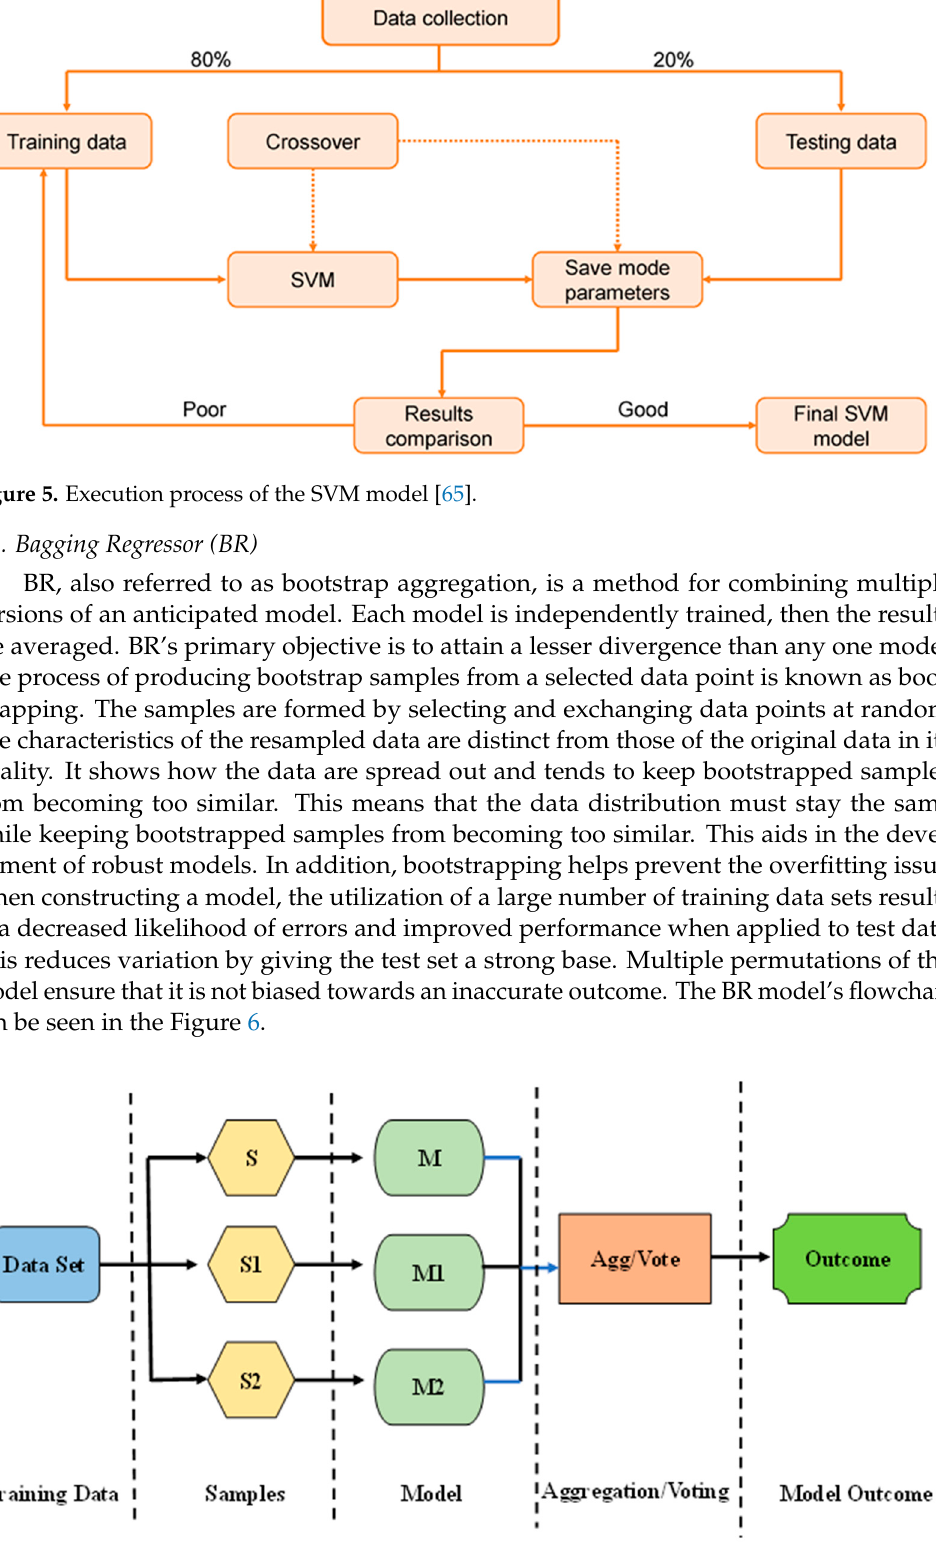
Figure 6. Bagging model execution process for required output.